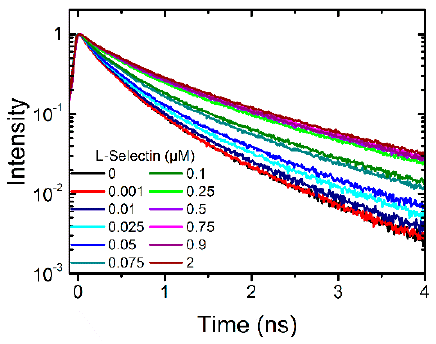
Figure 2. Fluorescence lifetime curves of 0.1 µM dPGS-ICC alone and with 11 different concentrations of soluble L-selectin-IgG chimera (0.001 µM to 2 µM) in DPBS at 20 °C.